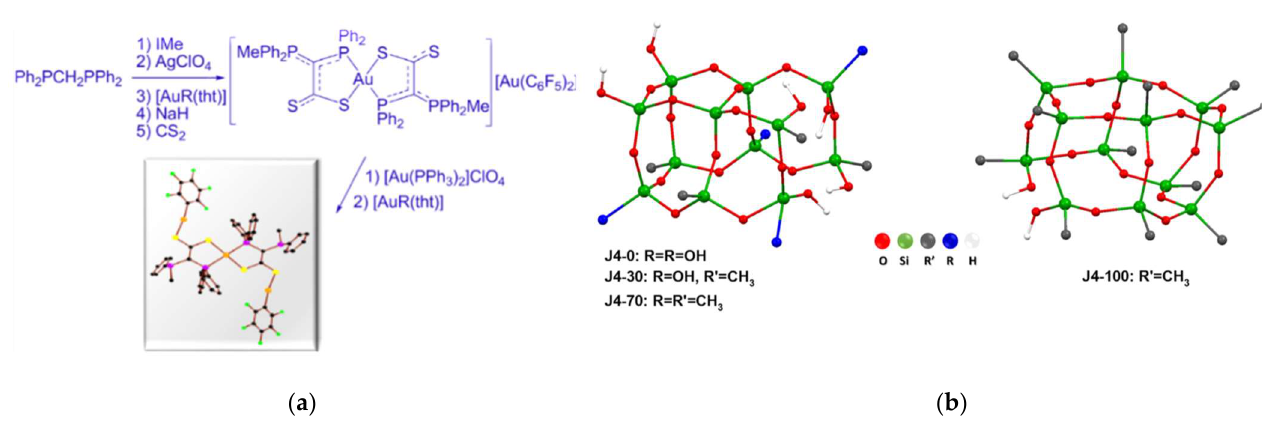
Figure 2. ( a ) Molecular structure (Ino-103) (taken from Laguna et al. 1998, Patent E-9802085); ( b ) Computational chemistry modeling of the ordered domains of a hybrid silicon xerogel (taken from Ospino et al. 2017).